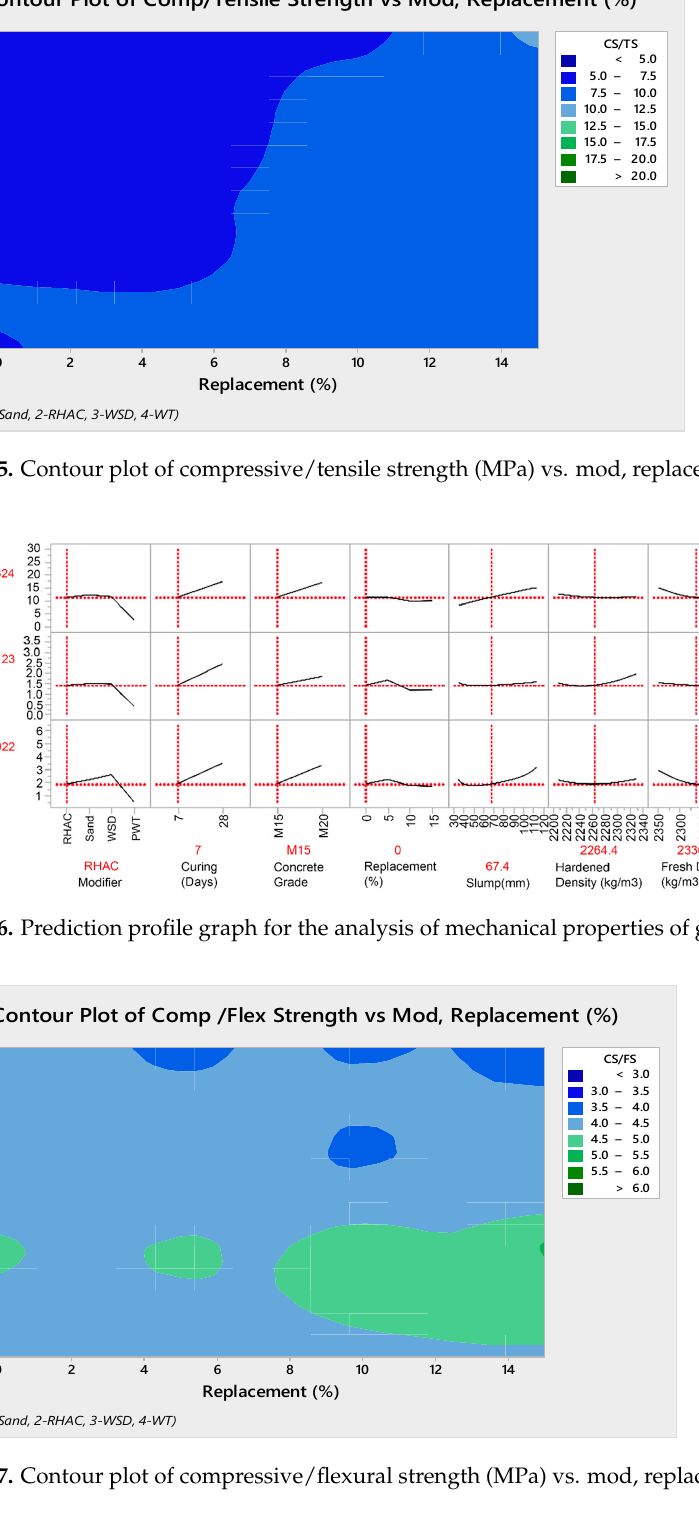
Figure 8. Contour plot of tensile/flexural strength (MPa) vs. mod, replacement (%). 3.3. ANNs Model Performance Fundamentally, in the construction of an artificial neural network, deep-conceptual engineering was involved. This system contains a backpropagation neural system that entails a comprehensive learning rate and momentum etc., that incorporates a set of nodes, hidden layers, and their orders. For cross-validation, a K-folded mechanism was employed to predict and validate the prediction of the ANNs model. To identify the pre- dictive power of the developed model, a relationship co-efficient like the co-efficient of determination ( R 2 ) plus root-mean-square error (RMSE) was employed. Additionally, a